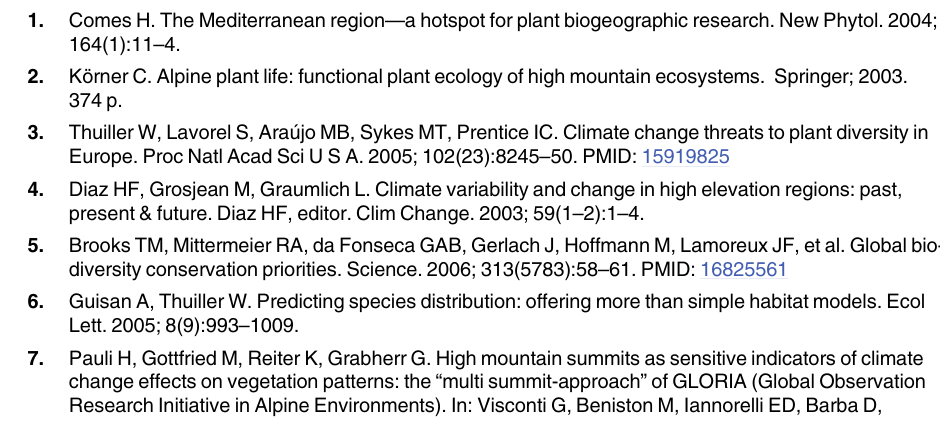
S1 Fig. Winter potential snow accumulation map. Winter potential snow accumulation cal- culated in Andorra following López-Moreno et al. (2007) using data from the Climatological Atlas of Andorra (Batalla et al. 2011). Dark blue tones indicate areas with high snow cover in winter and red areas indicate the current presence of the plant. S1 Table. Annual and winter Tmin, Tmax and precipitation values under climate change. Mean annual and winter (December, January and February) Tmin, Tmax and precipitation values for current reference values, for the mid-21st century (2021 – 2050) and for the end of the 21st century (2071 – 2100) under three climate change scenarios (A1B, A2 and